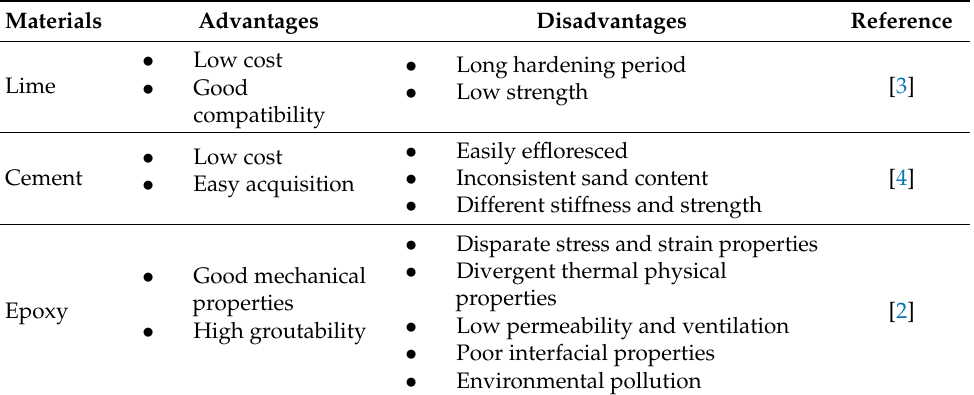
Table 1. Advantages and Disadvantages of Commonly Used Materials for the Reinforcement of Masonry